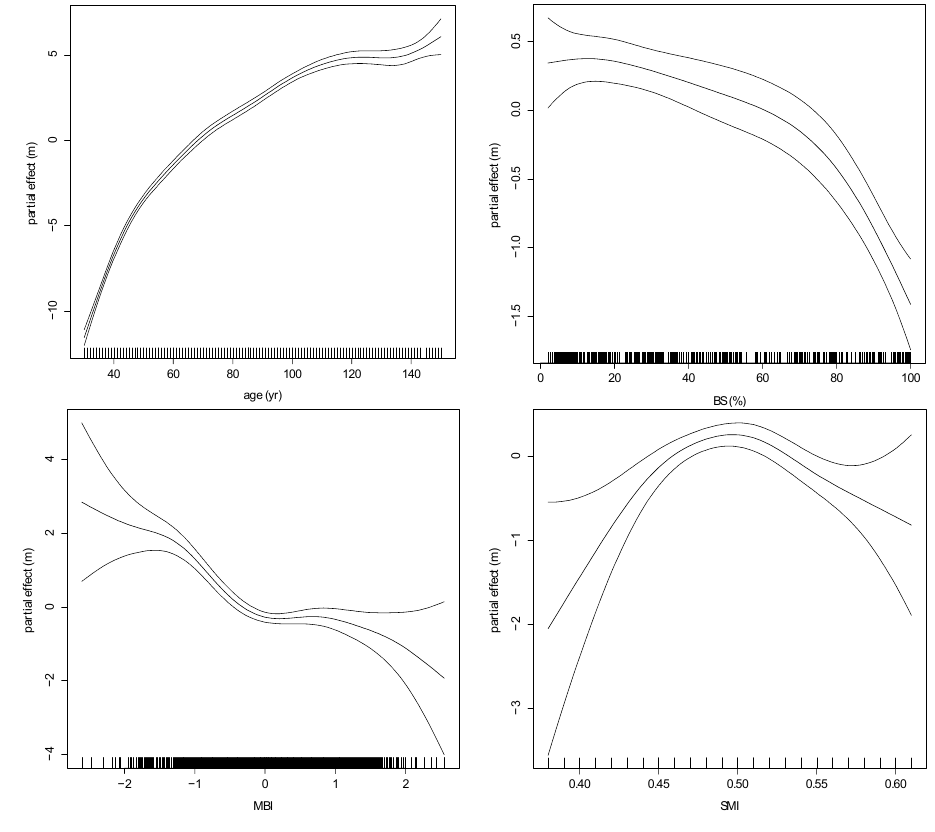
Figure 7. Partial effects of age, BS, MBI and SMI on height of Norway spruce. Dashed lines comprise 95% pointwise prognosis intervals; a rug plot shows the distribution of the